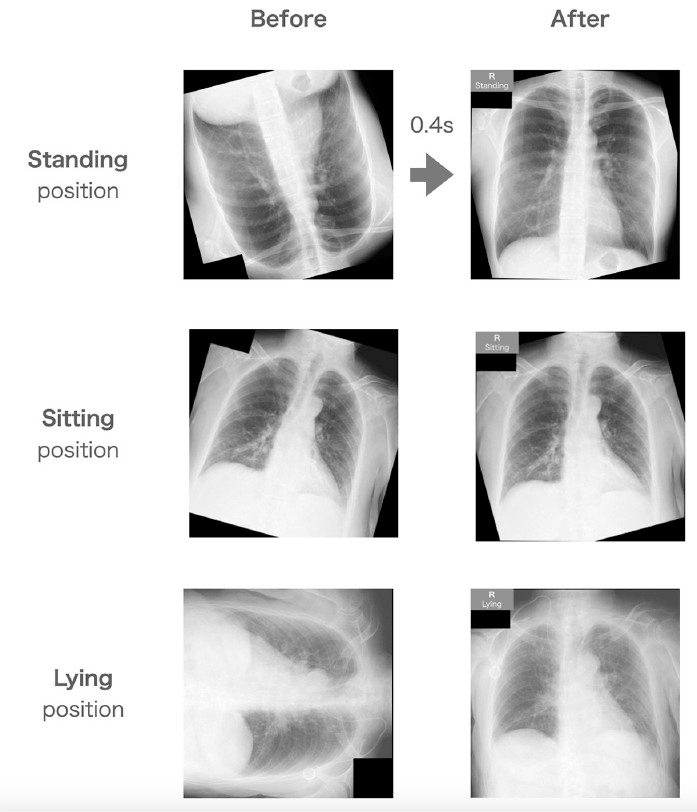
Figure 4. Images of each patient’s position before and after evaluation through the QA system. All images were perfectly corrected in their orientation, angle, and left–right reversal.